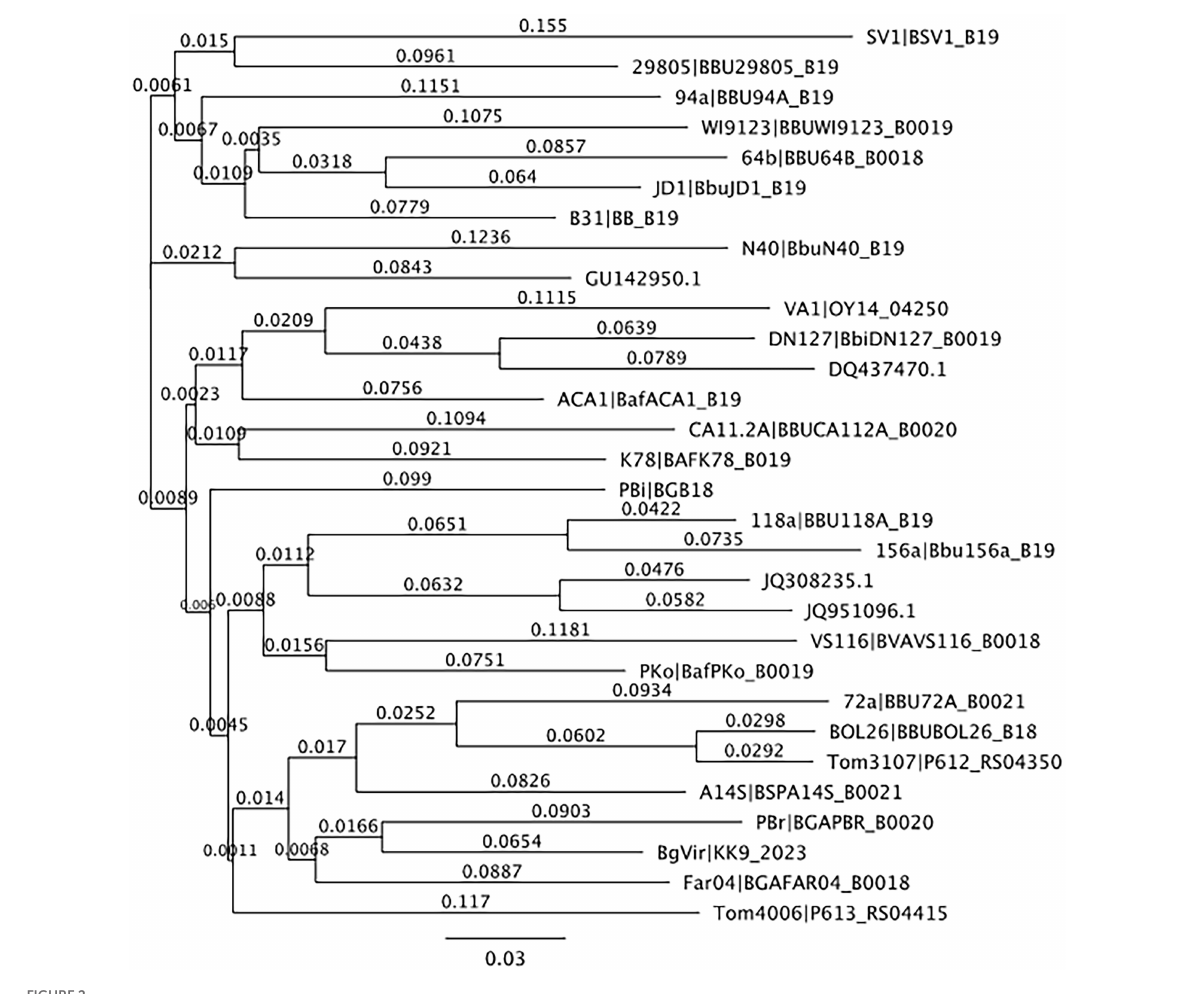
FIGURE 2 Neighbor-joining tree of reference sequences mapped to samples from this study. Neighbor-joining tree of OspC references observed in samples from this study created using Geneious version 10.0 created by Biomatters. Available from http://www.geneious.com.